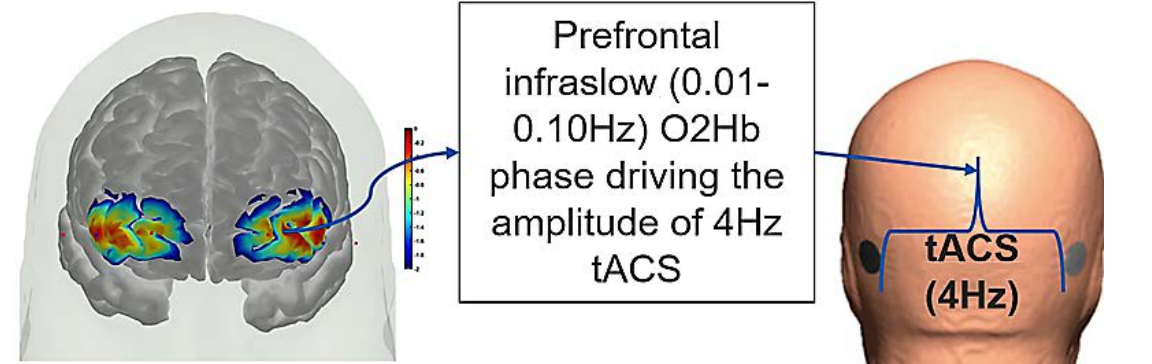
Figure 10. Illustration of the PFC phase–amplitude-coupled cerebellar tACS approach. Phase of the infra-slow (0.01–0.10 Hz) oxyhemoglobin (O2Hb) oscillations at the left PFC driving the amplitude of the 4 Hz cerebellar tACS optimized for targeting the lobules VI–CrusI/II–VIIb. Ten young and healthy right-handed subjects (8 males and 2 females, 21–25 years of age) volunteered for this study [122]. The session consisted of a block design of 2.5